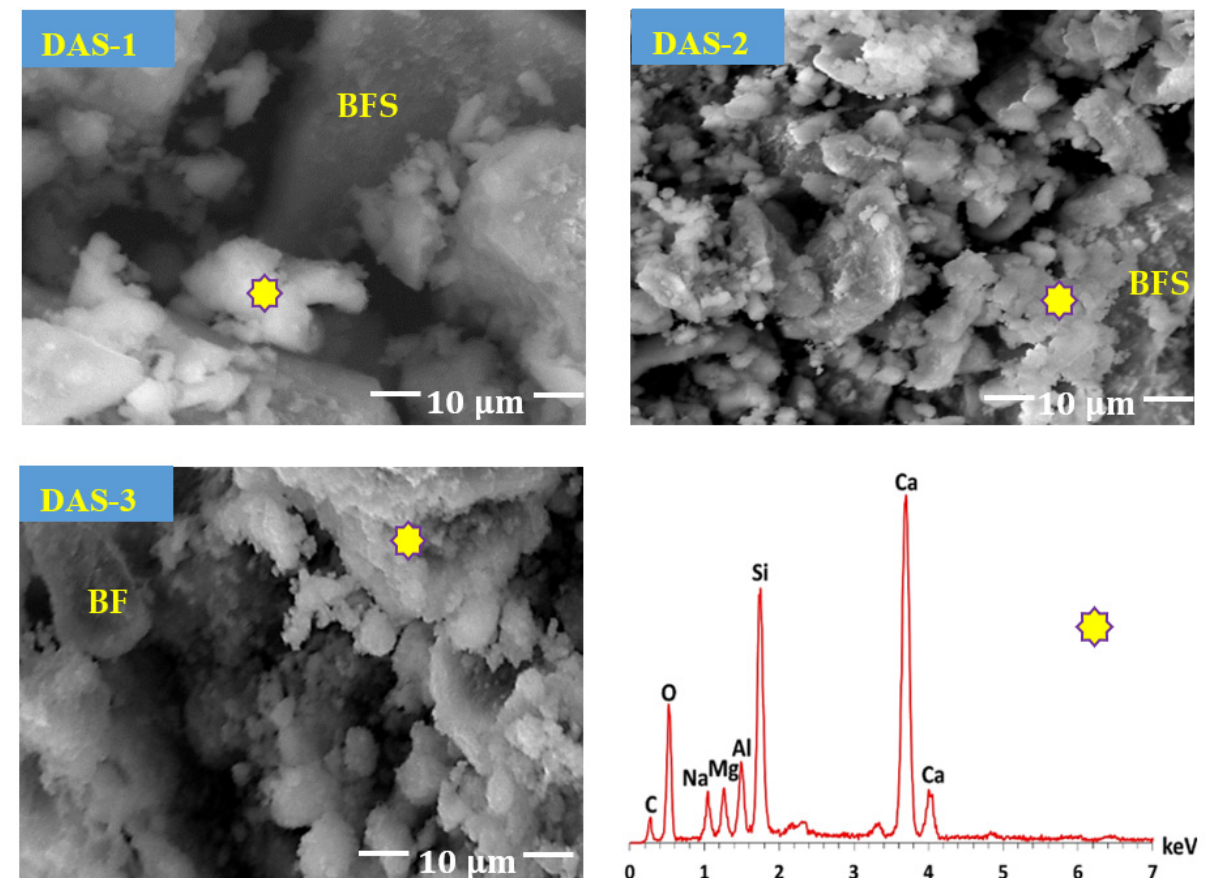
Figure 1. FESEM-micrographs and EDS-analysis of DAS-powders containing different NaOH contents.